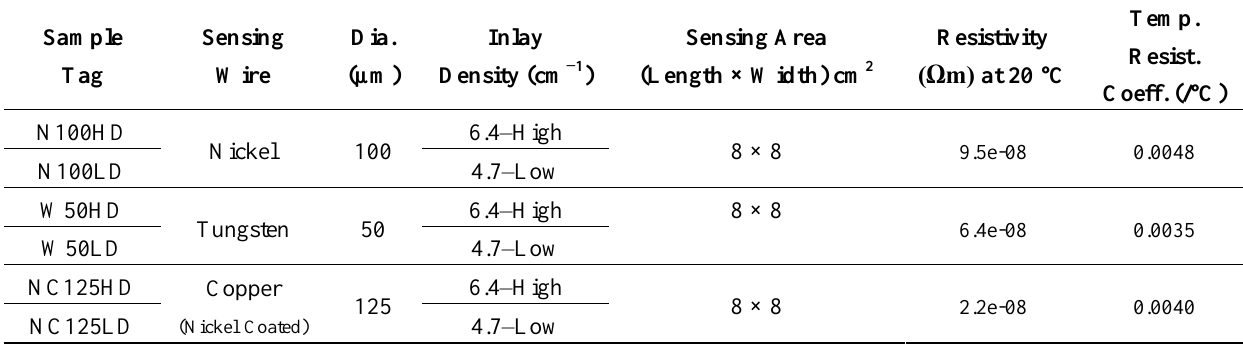
Table 1. Categories of TSF samples along with parameters for